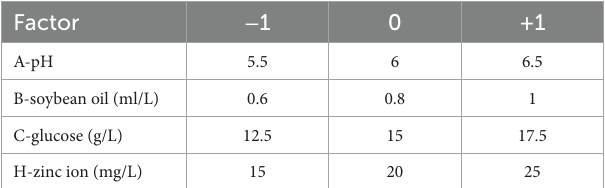
TABLE 1 Design of box-Benhnken experiment.